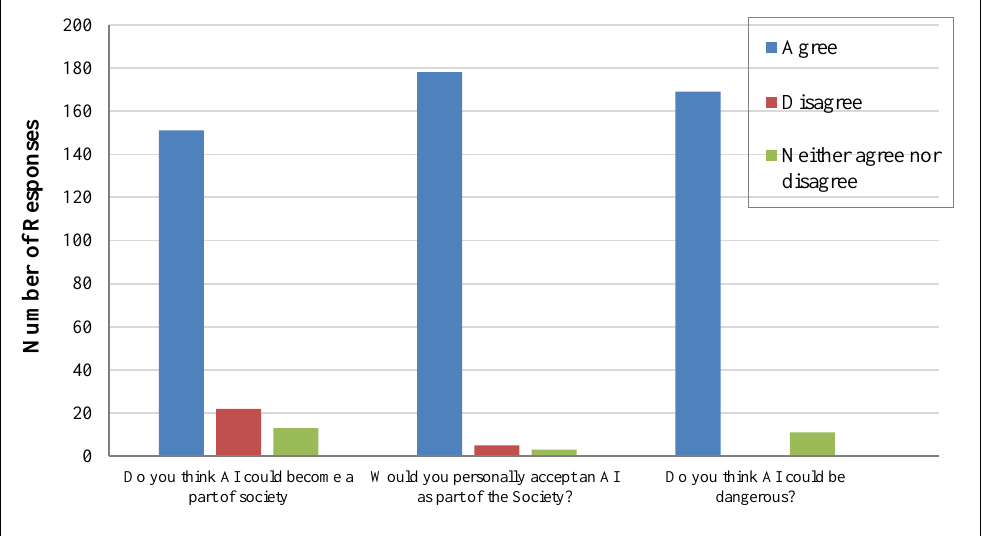
Figure 7. Acceptance of AI to be Part of the